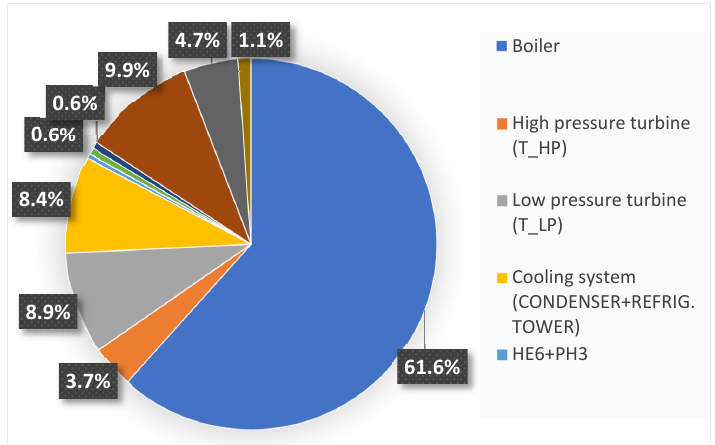
Figure 3. Exergy destruction share of the plant components.